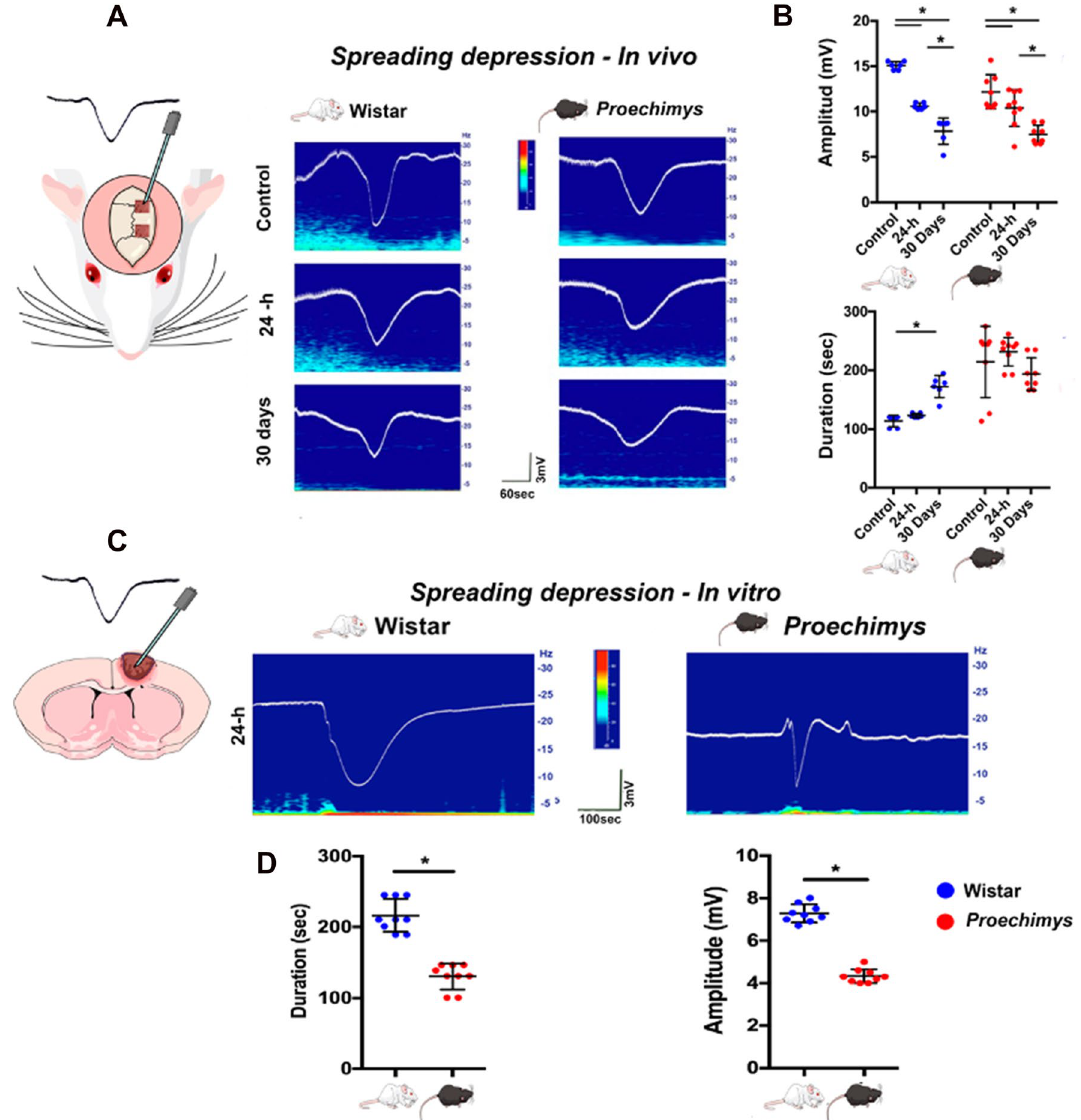
Figure 6. Spreading depression recordings in Wistar and Proechimys . ( A ) Representative recordings of spreading depression (SD) activity and its corresponding spectrogram in both animal species. ( B ) Statistical analysis of amplitude and duration of in vivo cortical SD recordings. In both animal species, all groups showed differences in the amplitude of SD: in Wistar (F = 98.53; p ≤ 0.0001); in Proechimys (F = 15.19; p ≤ 0.0001). Control vs 24-h, control vs 30 days, 24-h vs 30 days (Tukey’s multiple comparison test). In the duration of SD, Wistar rats showed differences between control vs 30 days (H = 13.24 p ≤ 0.0001) (Tukey’s multiple comparison test). Note that no differences were found in Proechimys . ( C ) Representative SD-like activity and its corresponding spectrogram in both animal species at 24-h after stroke. ( D ) Statistical analysis comparisons between animal species showed lower amplitude and duration of SD-like activity in Proechimys . Nonparametric test Mann–Whitney U = 0 *p < 0.0001. For the SD recording samples of the frequency spectrum, time and amplitude are both given by calibration bars. Graphs are represented as median with 95% CI. Figure was created in the Mind the Graph platform http:// www. mindt hegra ph. com under Creative Commons License CC community as “attribution share-alike4.0 licensing” https:// creat iveco mmons. org/ licen ses/ by/4.